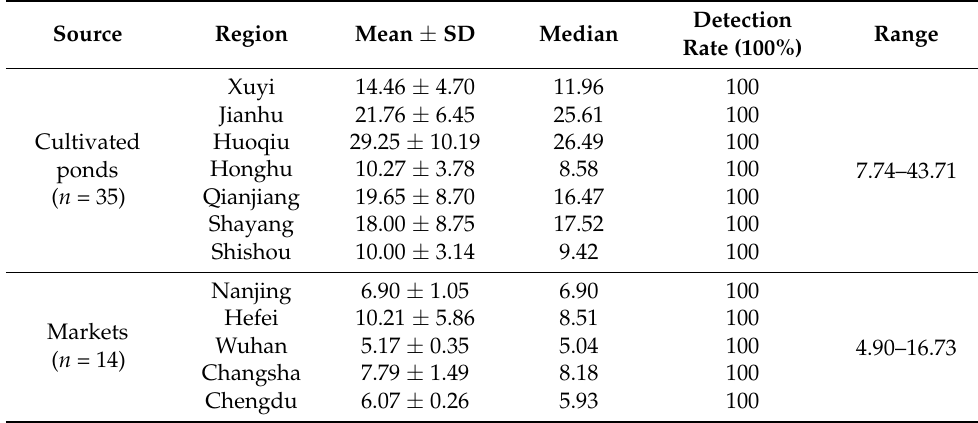
Table 1. Perchlorate levels of crayfish in cultivated ponds and sold in markets ( µ g/kg). Source Region Mean ± SD Median